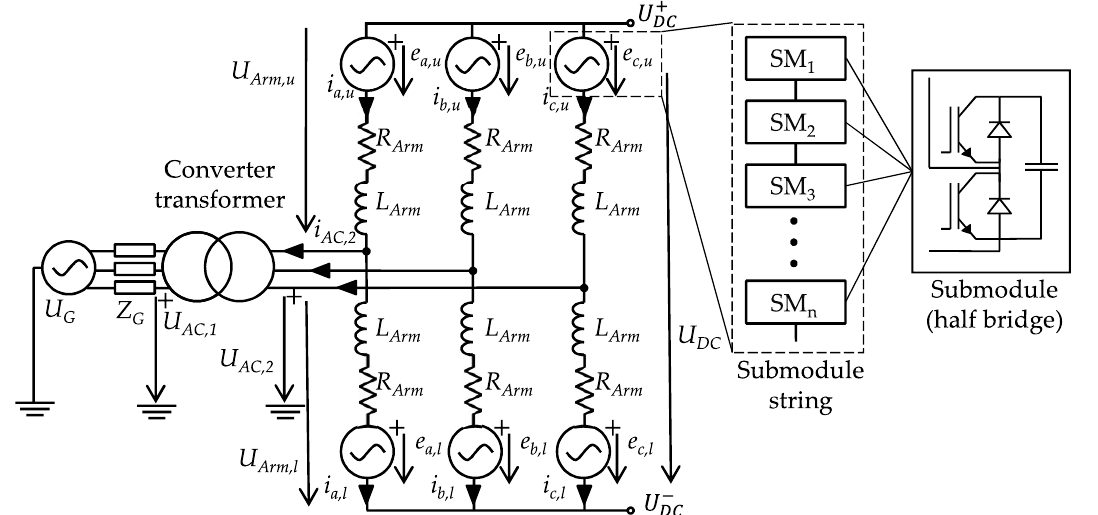
Figure 5. MMC connected to AC